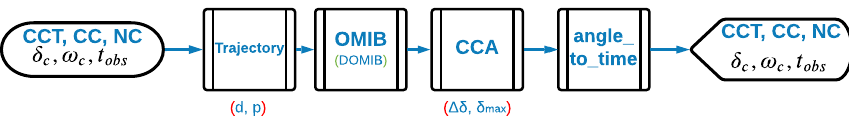
Figure 17. First refinement scheme to improve the estimation of the